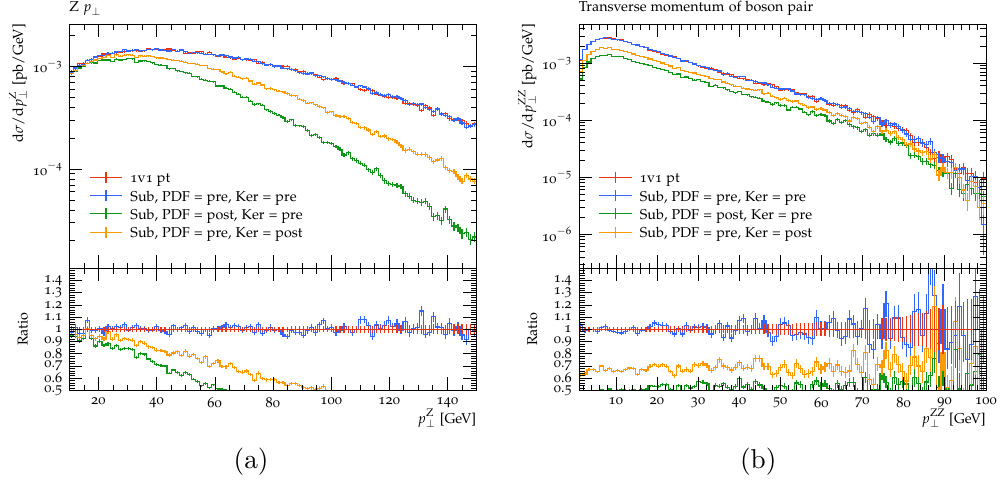
Figure 6 . (a) Transverse momenta of the Z 0 bosons and (b) transverse momentum of the Z 0 Z 0 pair for di(cid:11)erent values of the momentum fractions X used in equation (3.28). The label \PDF" refers to the momentum fractions used in the gluon PDFs, whereas \Ker" labels the fractions in the splitting kernels. In both cases, these fractions are set to be either the pre-kick fractions or the post-kick ones. The scale (cid:22) is set to be equal to M Z . The 1v1,pt setup is the reference in the ratio plots. The histograms are not normalised to unity.